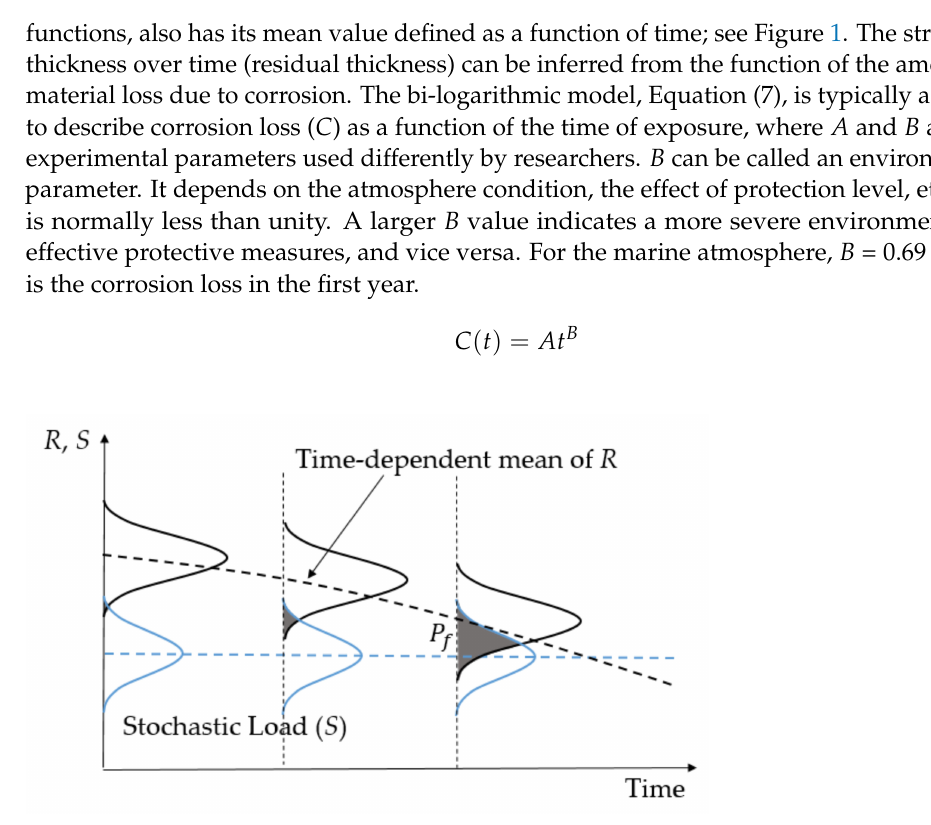
Figure 1. Stochastic process of load effect S ( t ) and the deteriorating structural resistance R ( t )